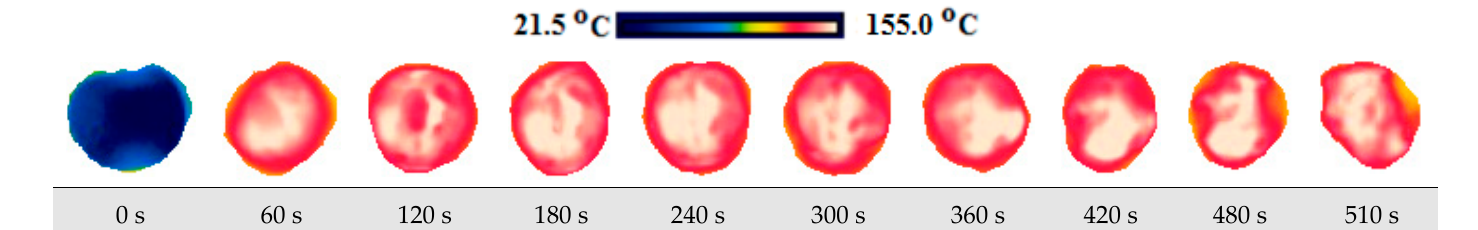
Figure 15. Thermal images of persimmon with 7 mm at 350 W.